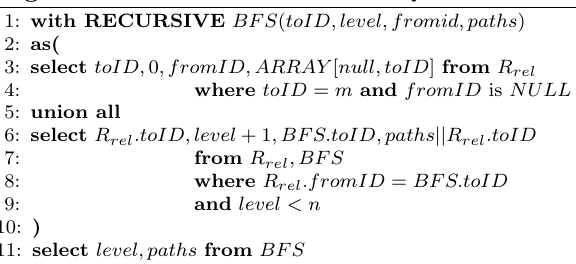
Algorithm 3 Bread-First Search in SQL